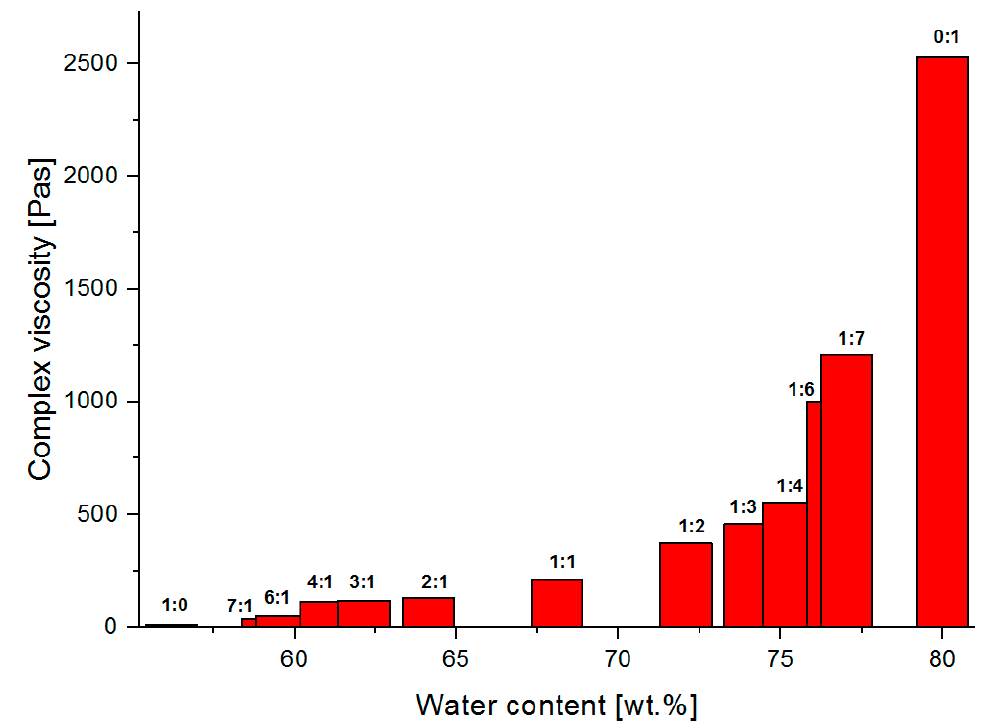
Figure 11. The dependence of the complex viscosity versus water content of the tested polymer-silicate hydrogel samples.